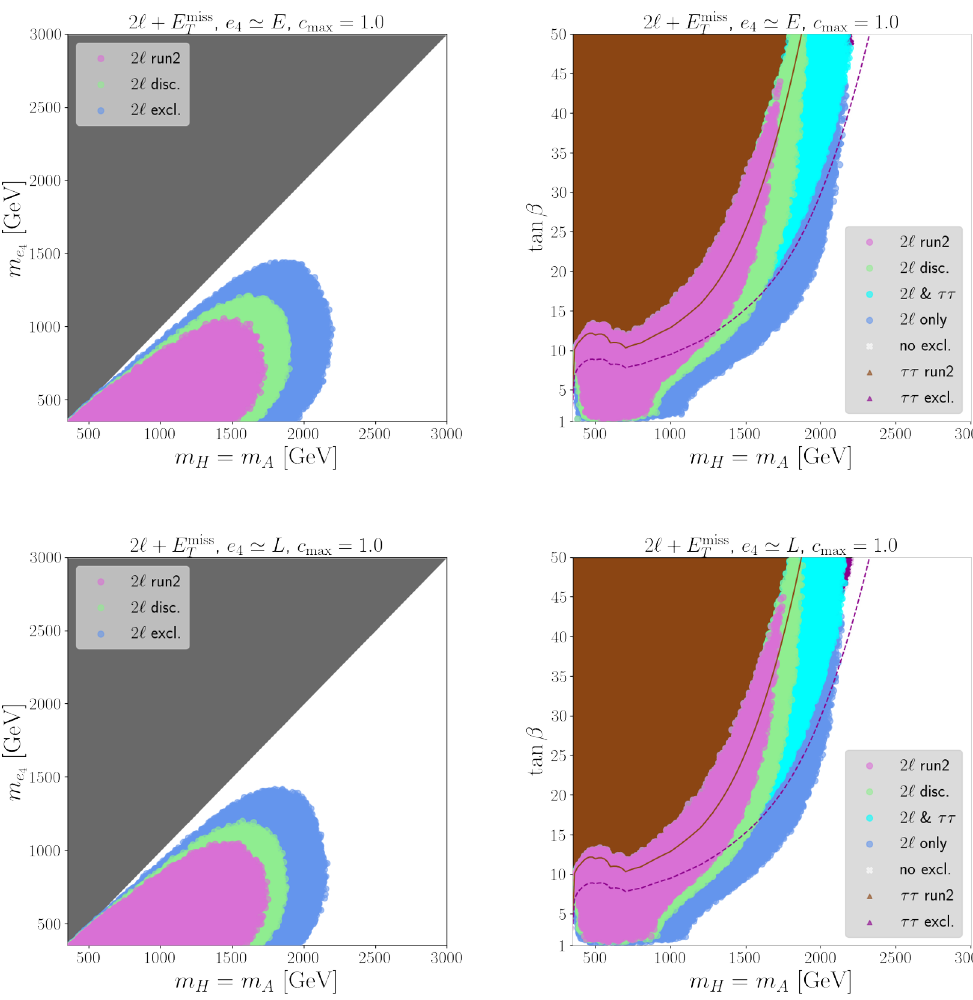
Figure 12 . Sensitivities of the 2 ‘ + E miss search to the light-E (light-L) scenario with c max = 1 T in the upper (lower) panels. In the labels, “ 2 ‘ ” is a short for 2 ‘ + E miss search and “ ττ ” is the T di-tau search. In addition, “run2”, “disc.” and “excl.” indicate that the points are constrained by the current run-2 data, expected to be discovered and constrained by the future HL-LHC data, respectively. See the texts for more